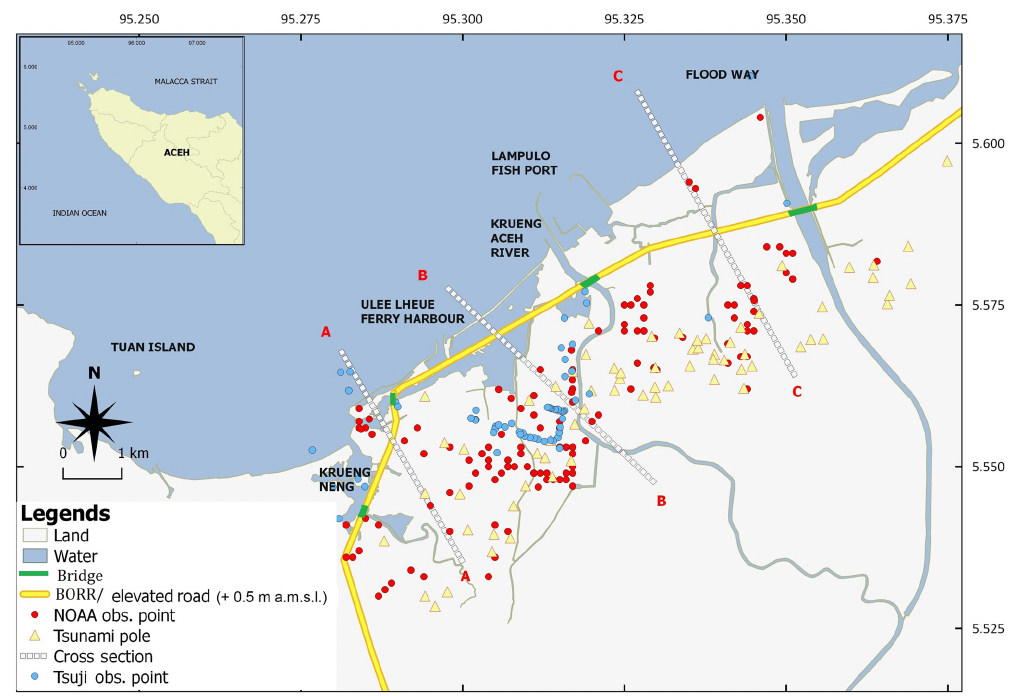
Figure 1. The study area. The elevated road (yellow line) is part of the city’s development planning documents. There are 139 points of the 2004 tsunami heights measured by NOAA (red dots) (NOAA, 2018) and 56 locations of tsunami poles representing water marks based on eyewitness accounts (yellow triangles).